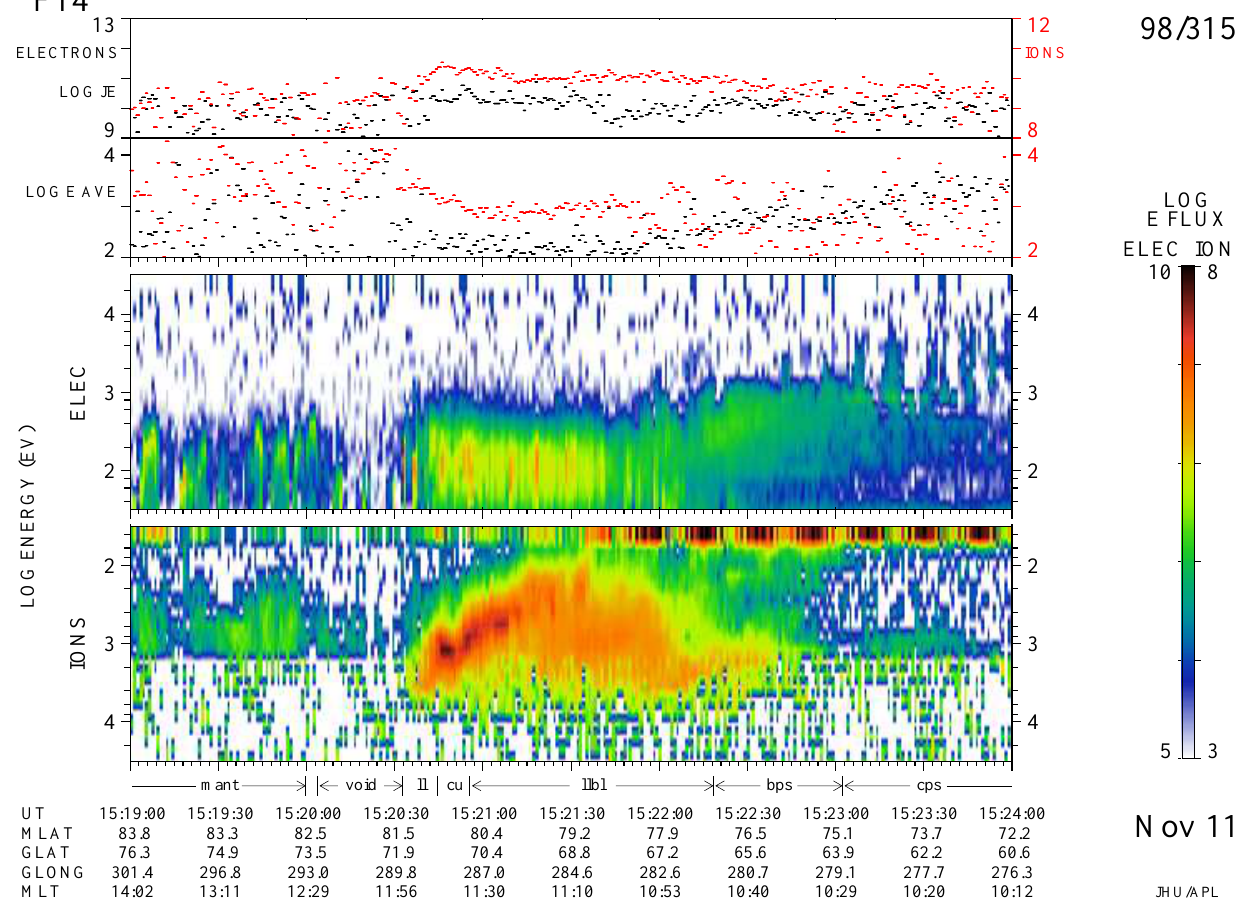
Fig. 5. DMSP-F14 measurements of ion and electron precipitation during the interval 15:19–15:24 UT on 11 November 1998. The panels, from top to bottom, show integral energy flux in units of eV/cm 2 ssr, average energy in eV, and the differential energy flux of electrons and ions in eV/cm 2 ssreV. Also shown are the classifications of precipitation regions as determined by the algorithm of Newell et al.